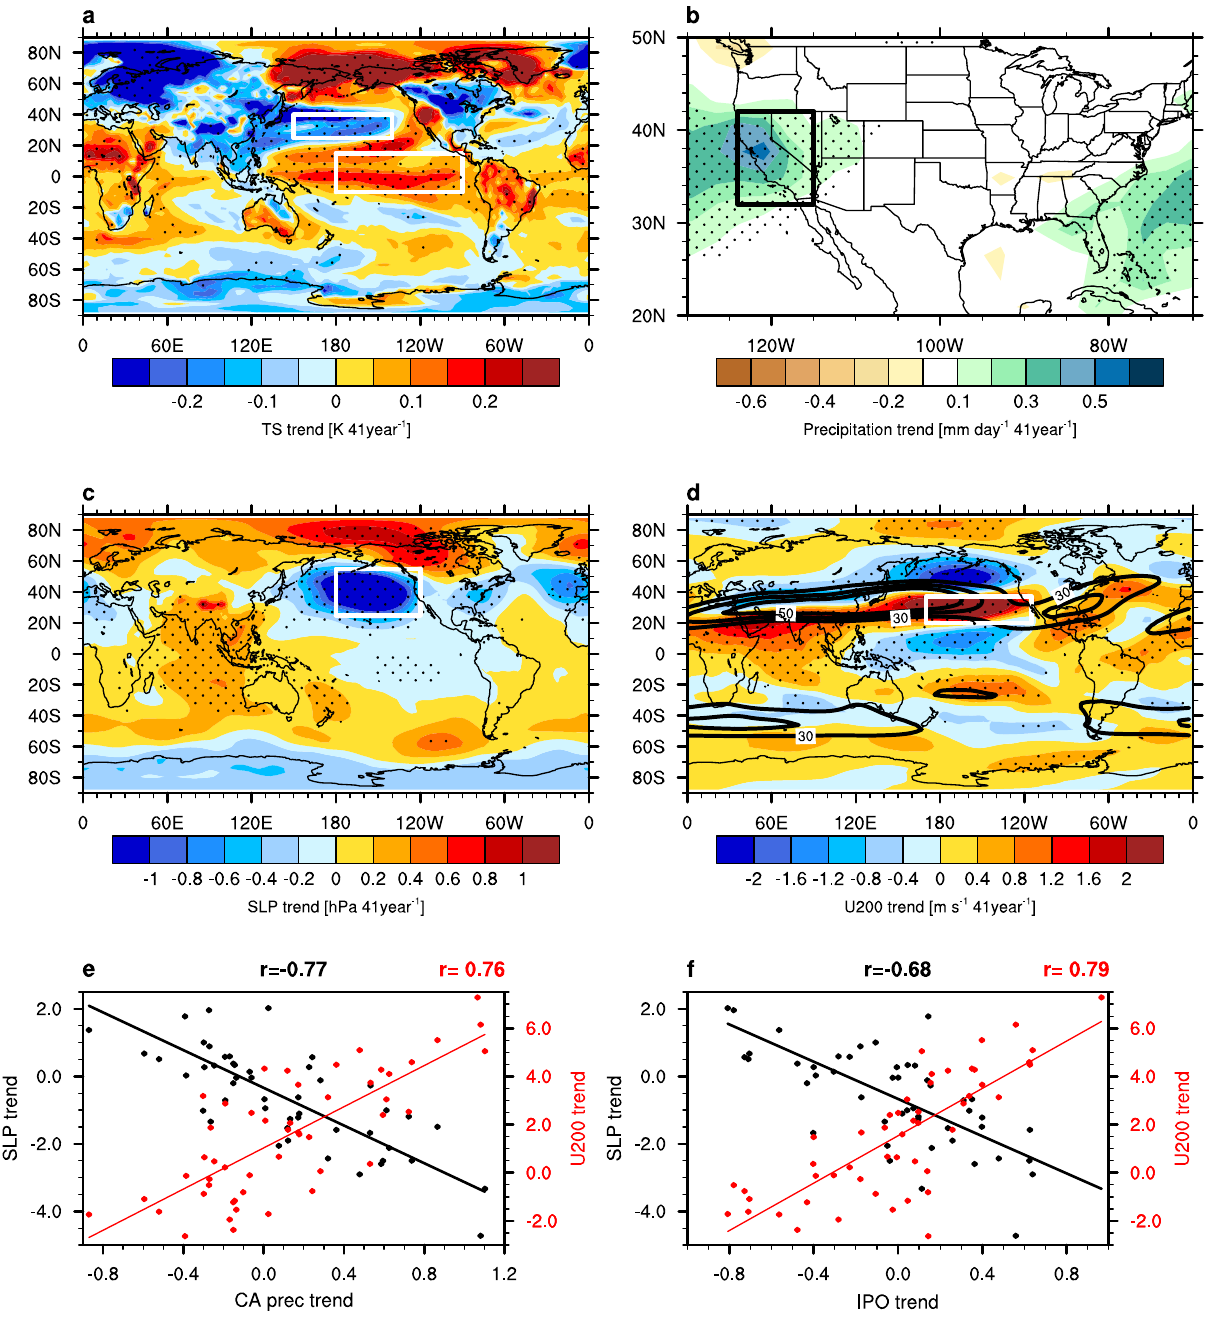
Fig. 2 The dominant internal mode in fl uencing the uncertainty of California precipitation decadal trends and the mechanism. Intermember regressions of a surface temperature (TS) trend (K 41year − 1 ) onto the California averaged precipitation (CA prec) trend. Intermember regressions of the linear trend in b precipitation (mm day − 1 41year − 1 ), c sea level pressure (SLP; hPa 41year − 1 ), d 200hPa zonal wind (U200; m s − 1 41year − 1 ) onto the Interdecadal Paci fi c Oscillation (IPO) trend. Scatterplots of e the California precipitation trend ( x -axis) and f the IPO trend ( x- axis) versus the SLP trend over the Aleutian low (black, left y -axis) and the zonal wind at 200 hPa (U200) trend over the jet extension region (red, right y -axis). The climatological jet stream based on the historical simulations is shown in black contours in panel d . All the trends are based on the 50 members of CanESM2 during 1979 – 2019. The regression lines and the intermember correlations (r) are shown in corresponding color on top of the bottom panels. The averaging areas for calculating the quantities shown in the bottom panels are indicated as rectangles in panels a to d